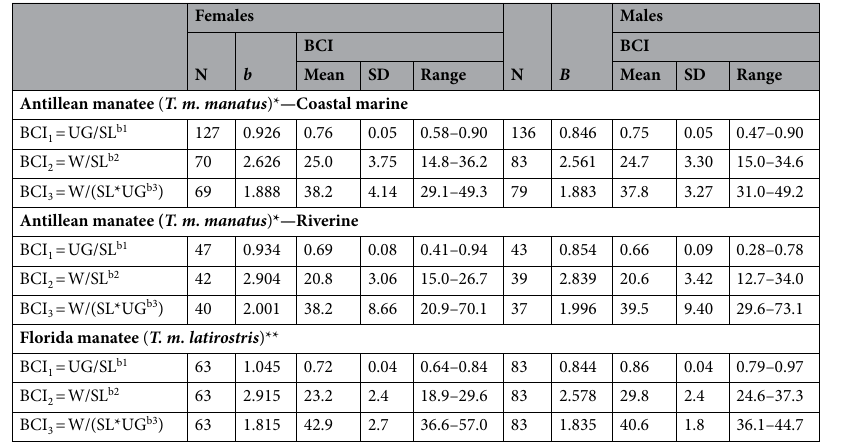
Table 5. Body condition indices (BCI) for West Indian manatees Trichechus manatus. W = body mass, UG = umbilical girth, SL = straight-line total length. * This study, **Harshaw et al . 2016.